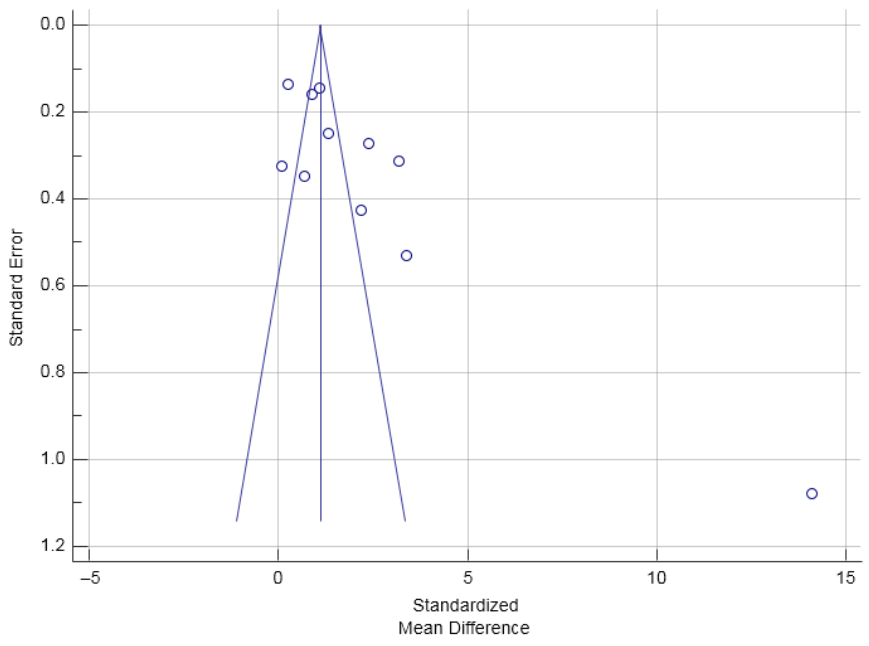
Figure 5. Funnel Plot examining trials of 25OHD responses with vitamin D supplementation.